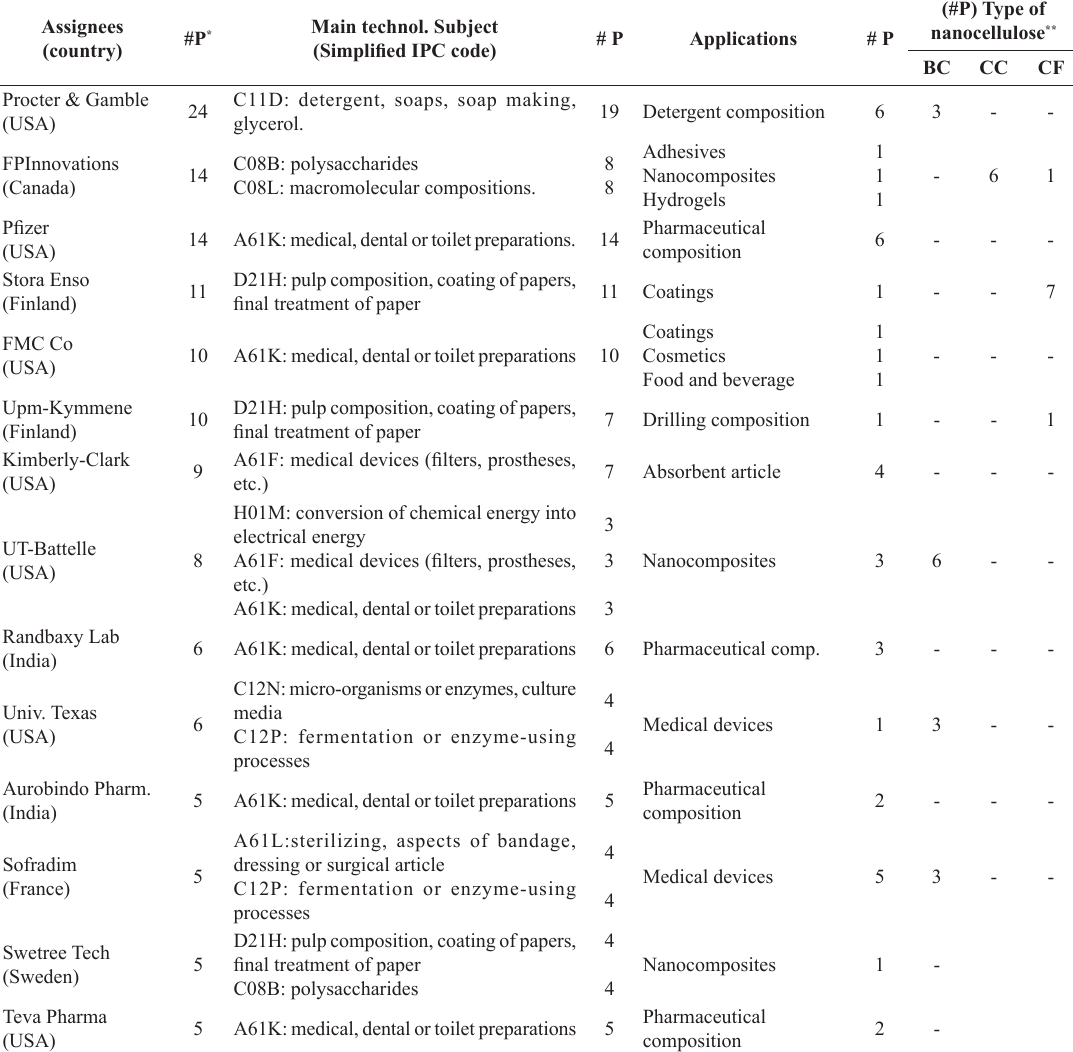
Table 2. Main assignee profile compiled from patent documents in nanocellulose. Assignees